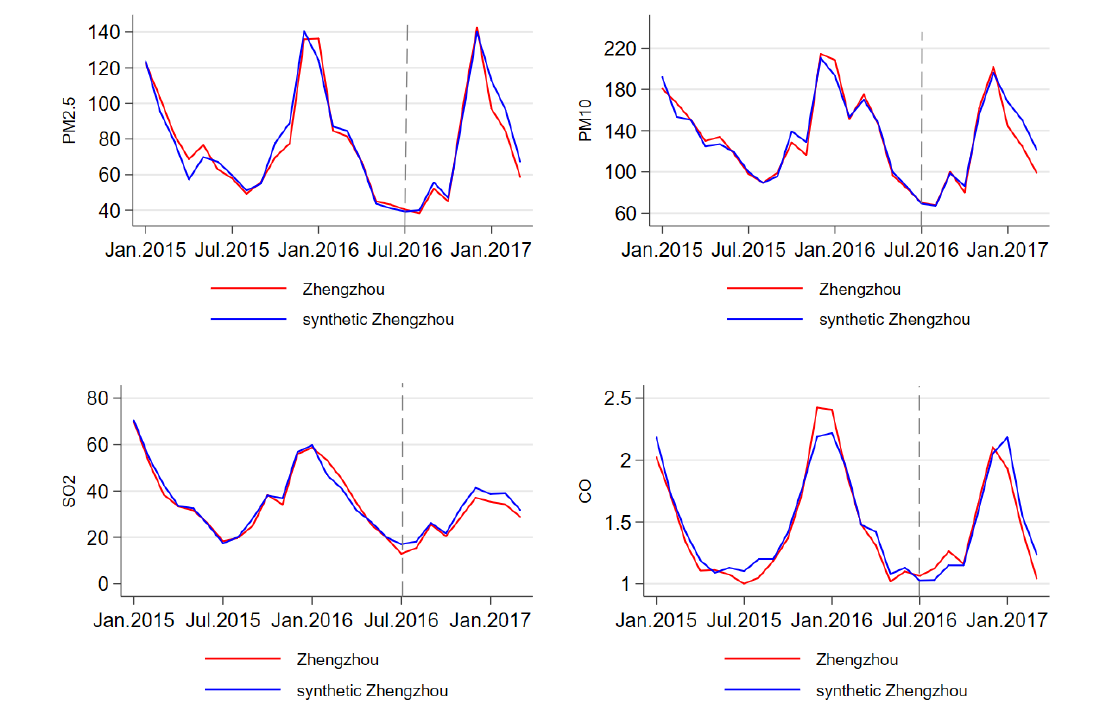
Figure 9. Individual pollutants in treatment regions and synthetic regions.